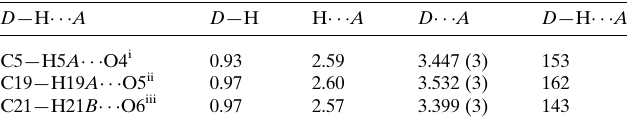
Table 1 Hydrogen-bond geometry (A˚ , (cid:2) ).